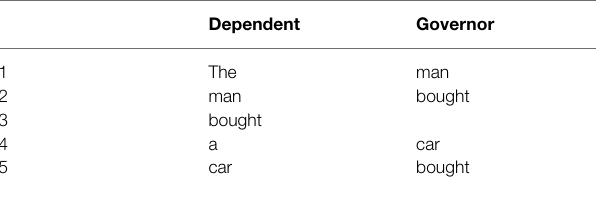
TABLE 2 | Dependency relations of the sample sentence extracted from the treebank.